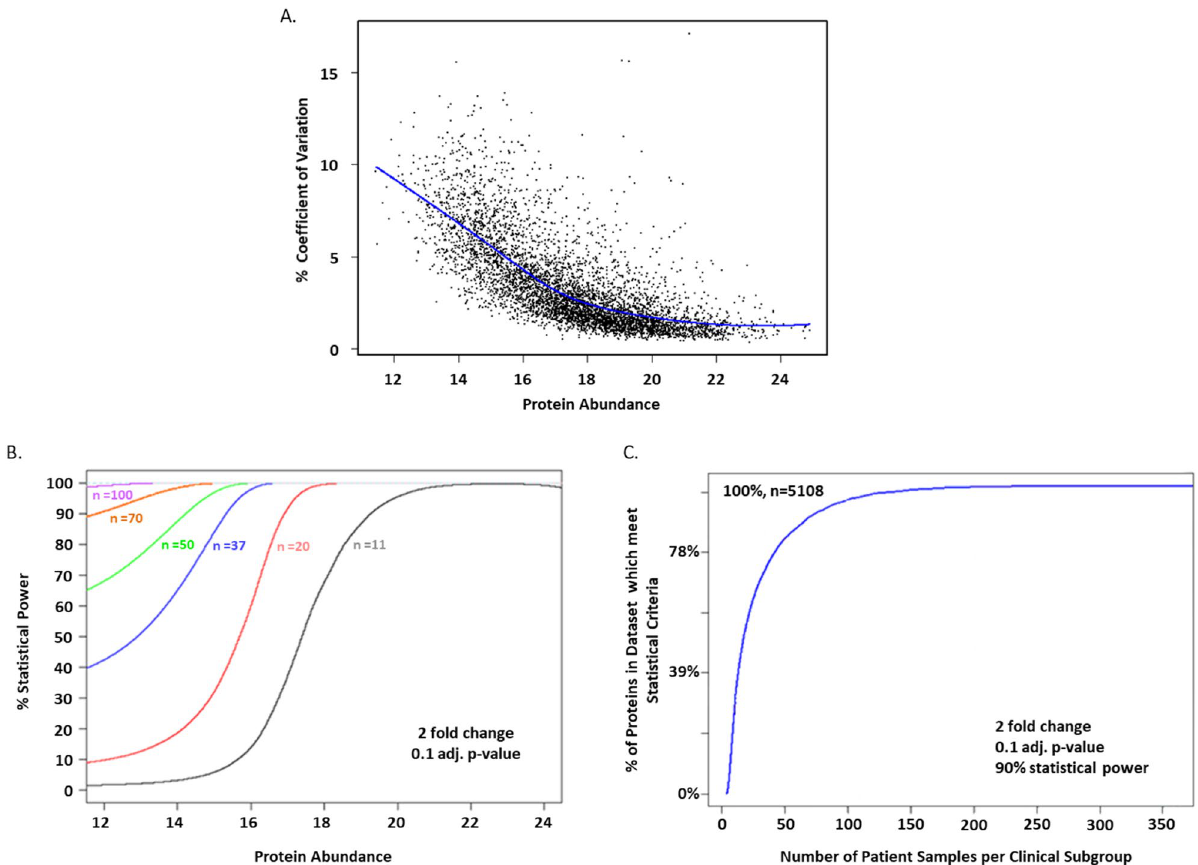
Figure 5. Error model exploration and statistical power analysis of SWATH-MS data. ( A ) Loess model best fit relationship between protein abundance measured by SWATH-MS (total number of proteins = 5108) and coefficient of variation (%). The plot shows that coefficient of variation (%) was higher in proteins expressed at a low abundances. ( B ) Plot of statistical power (%) against protein abundance measured by SWATH-MS (based on the Loess model). The plot shows that to detect a twofold change in protein expression level between clinical subgroups (based on IGHV status) to a Bonferroni corrected alpha of 0.1, both the protein abundance and the number of patient samples per clinical subgroup will influence the statistical power. A higher % statistical power is reached on proteins expressed at low abundances when larger numbers of clinical samples are used. ( C ) Sample size analysis plot based on the SWATH-MS data, showing the number of individuals required per CLL clinical subgroup (IGHV mutational status) to detect a twofold change in protein expression, at 90% Statistical power and to a Bonferroni corrected alpha of 0.1.